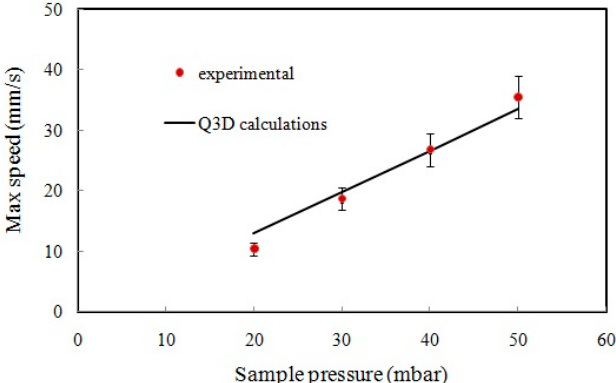
Figure 12. The experimental and Q3D calculated maximum flow speeds at the main microchannel of the chip as a function of the sample pressure.